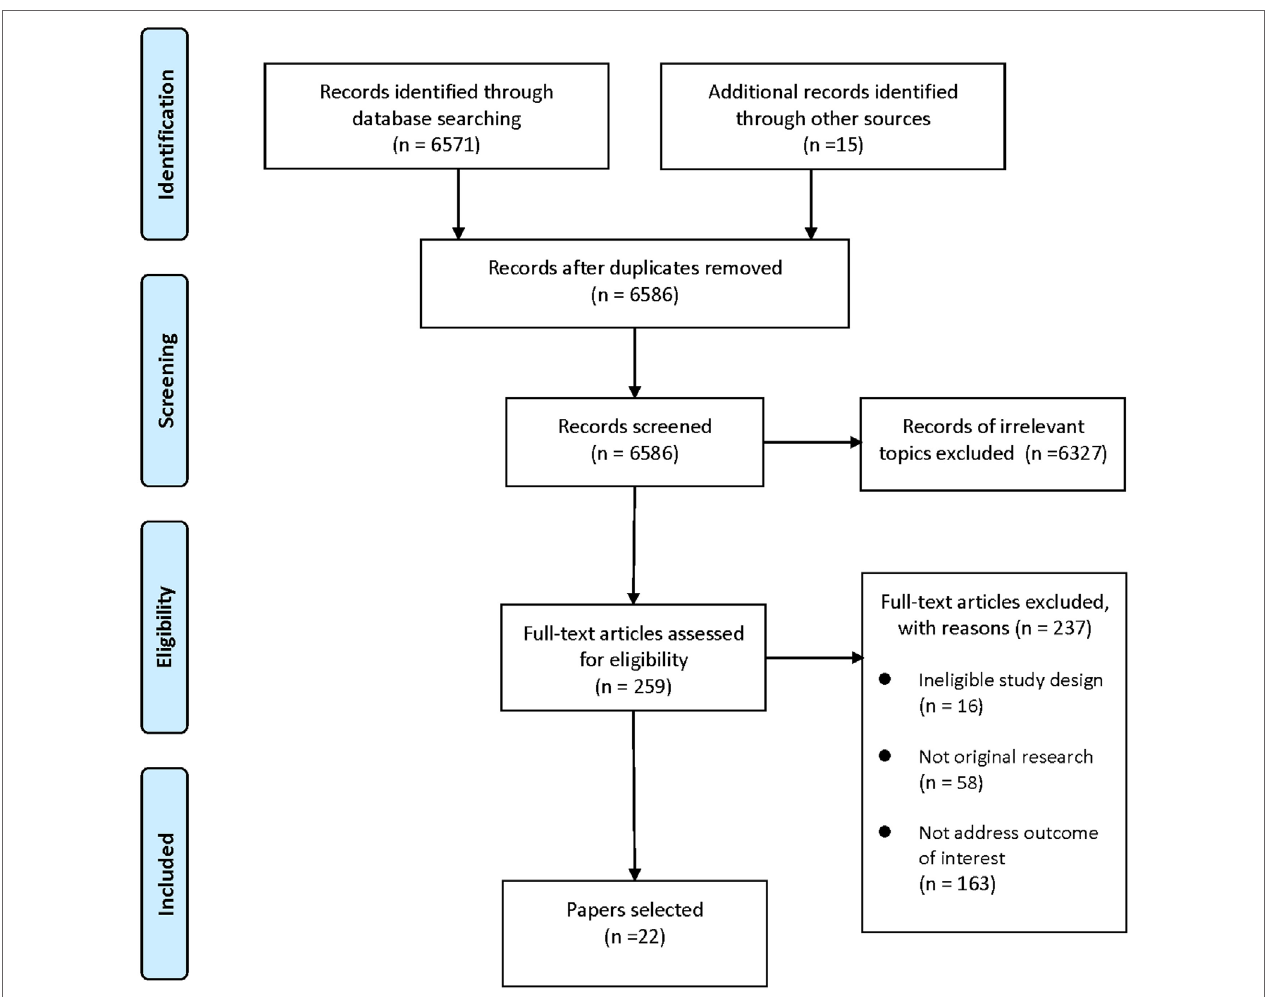
FiGURe 1 | Flow diagram of the study selection